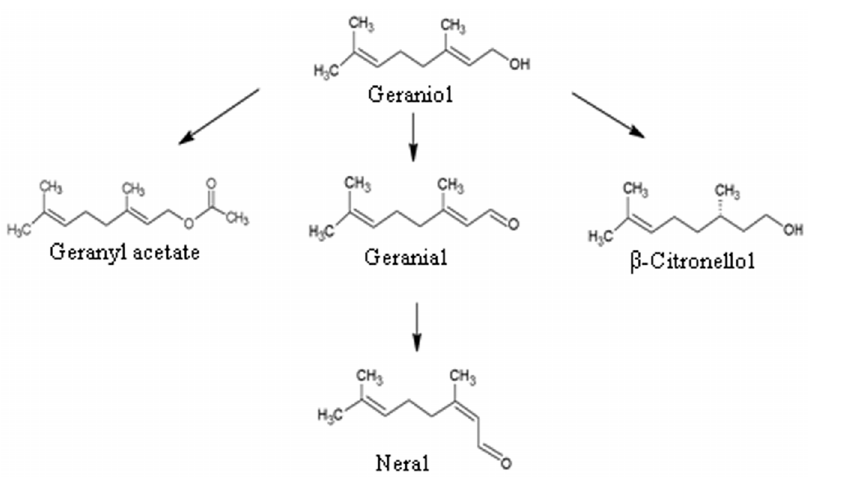
Figure 1. Monoterpenes used to study the plant responses. Geraniol can be metabolized into geranyl acetate, b -citronellol, geranial and neral by the action endogenous plant enzymes. The geometric isomers geranial and neral are known as trans -citral (citral-A) and cis -citral (citral-B), respectively.